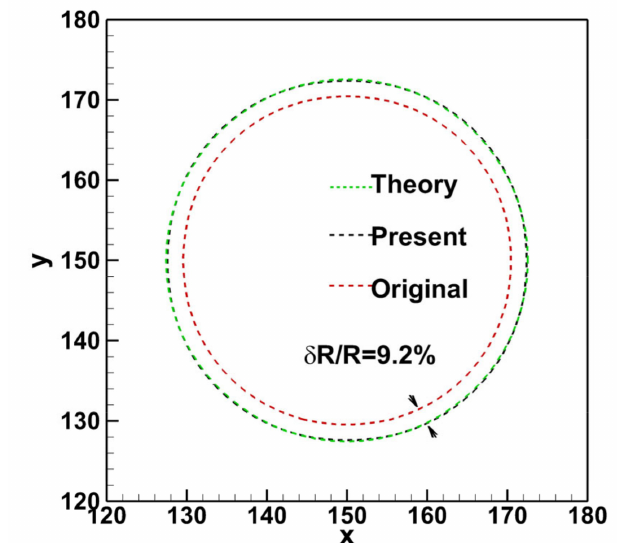
Figure 9. Contrast of the final interface for the bubble with R = 20 at σ = 0.005.